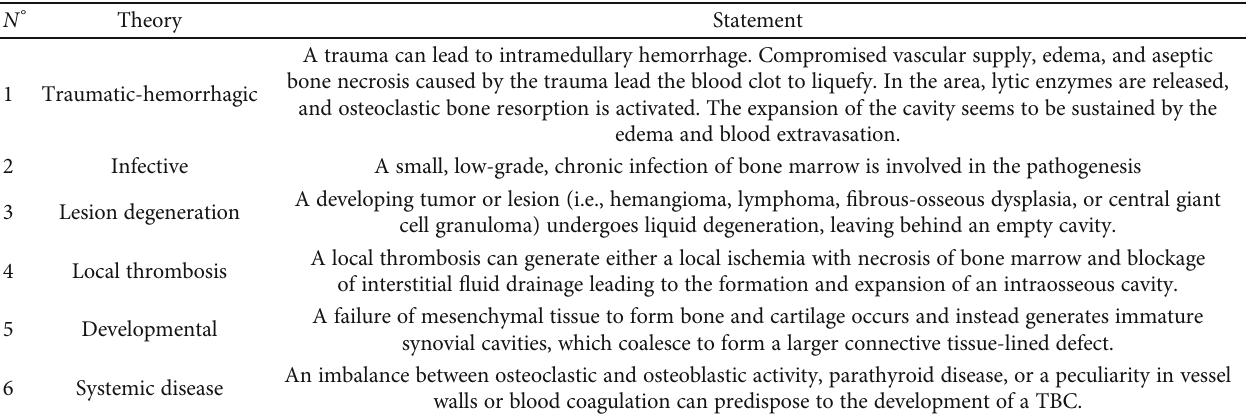
Table 1: Etiopathogenetic theories of the